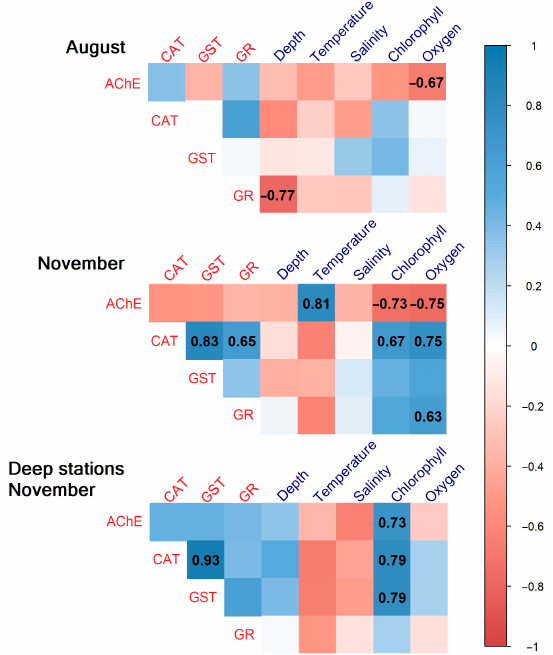
Figure 4. Spearman’s rank correlation coefficients between biomarker levels and physicochemical variables were calculated for six coastal stations in August and November, and for seven deep-water stations in November. Correlation coefficients (Spearman’s rho) with a p < 0.05 are shown and marked based on their sign (+ or − ) and strength (continuous color scale).